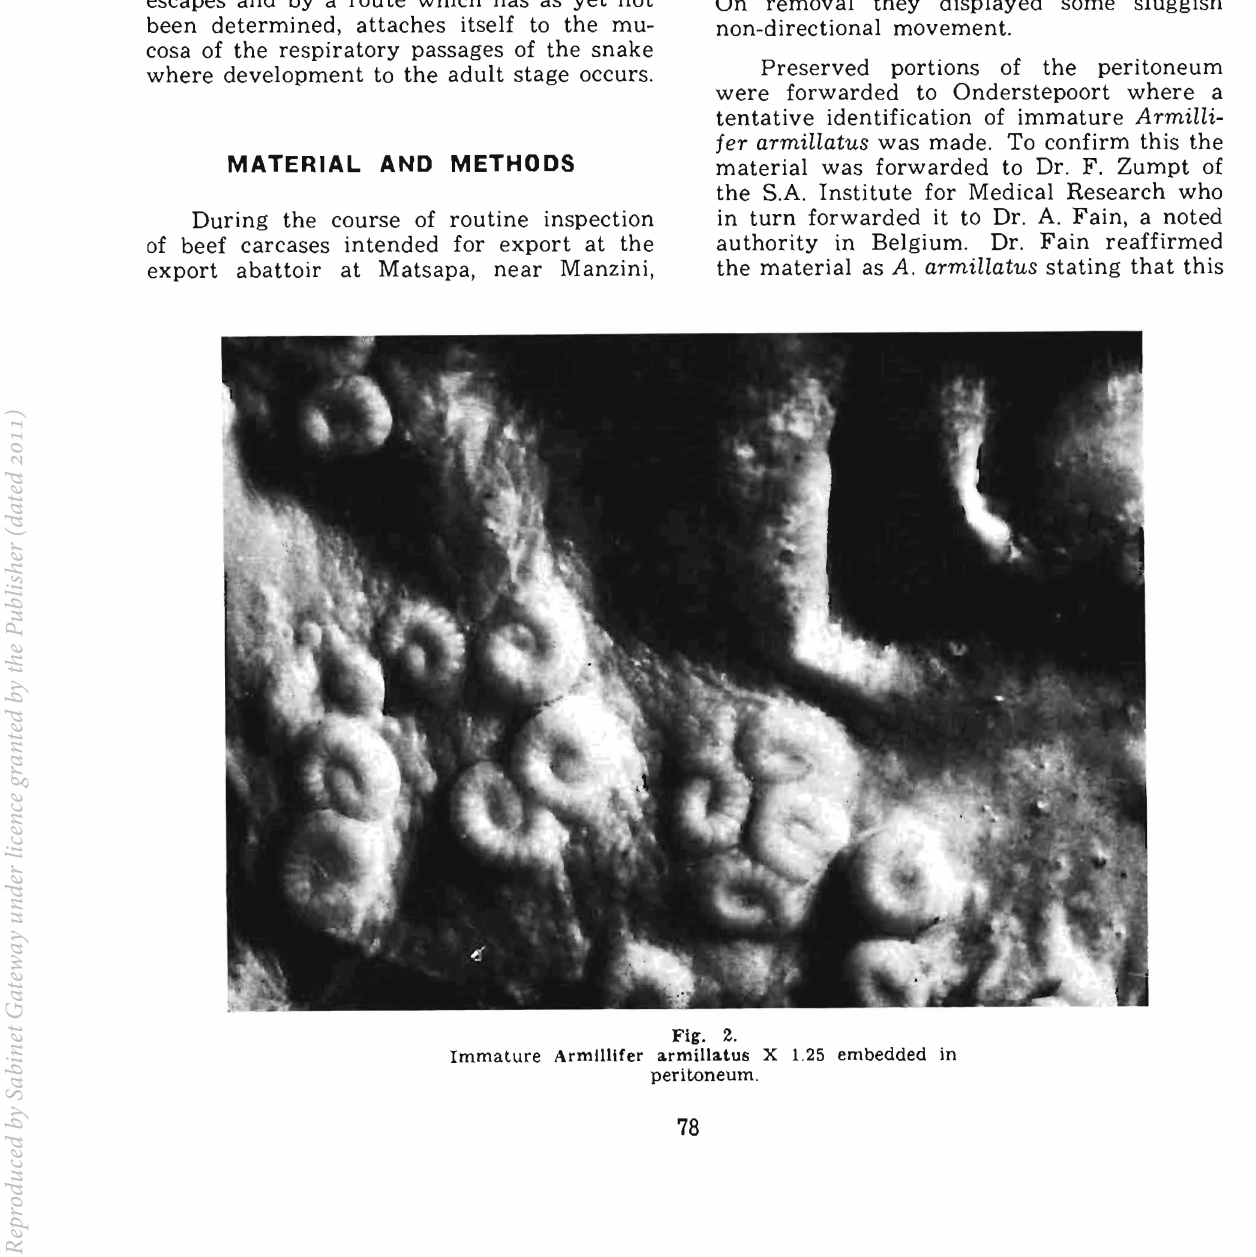
Immature Armlllifer armillatus X 1.25 embedded in